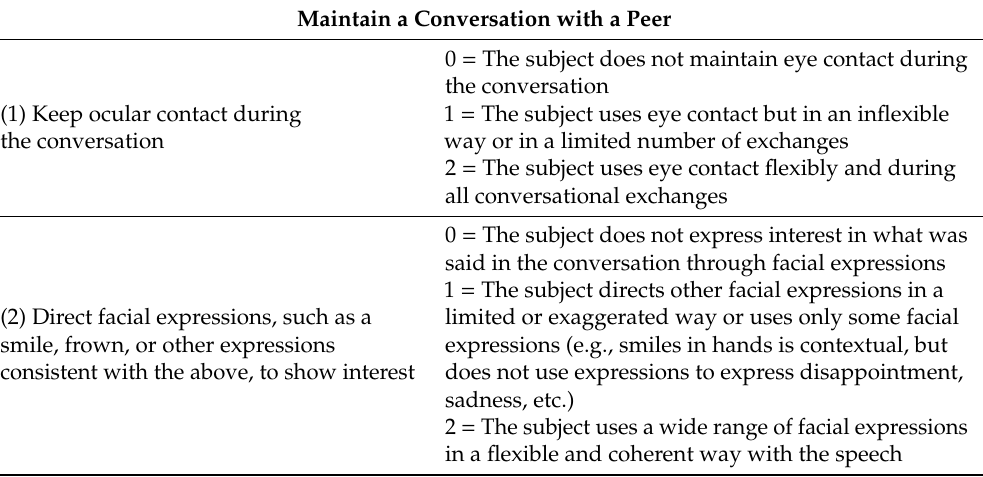
Table 1. Exemplification of a